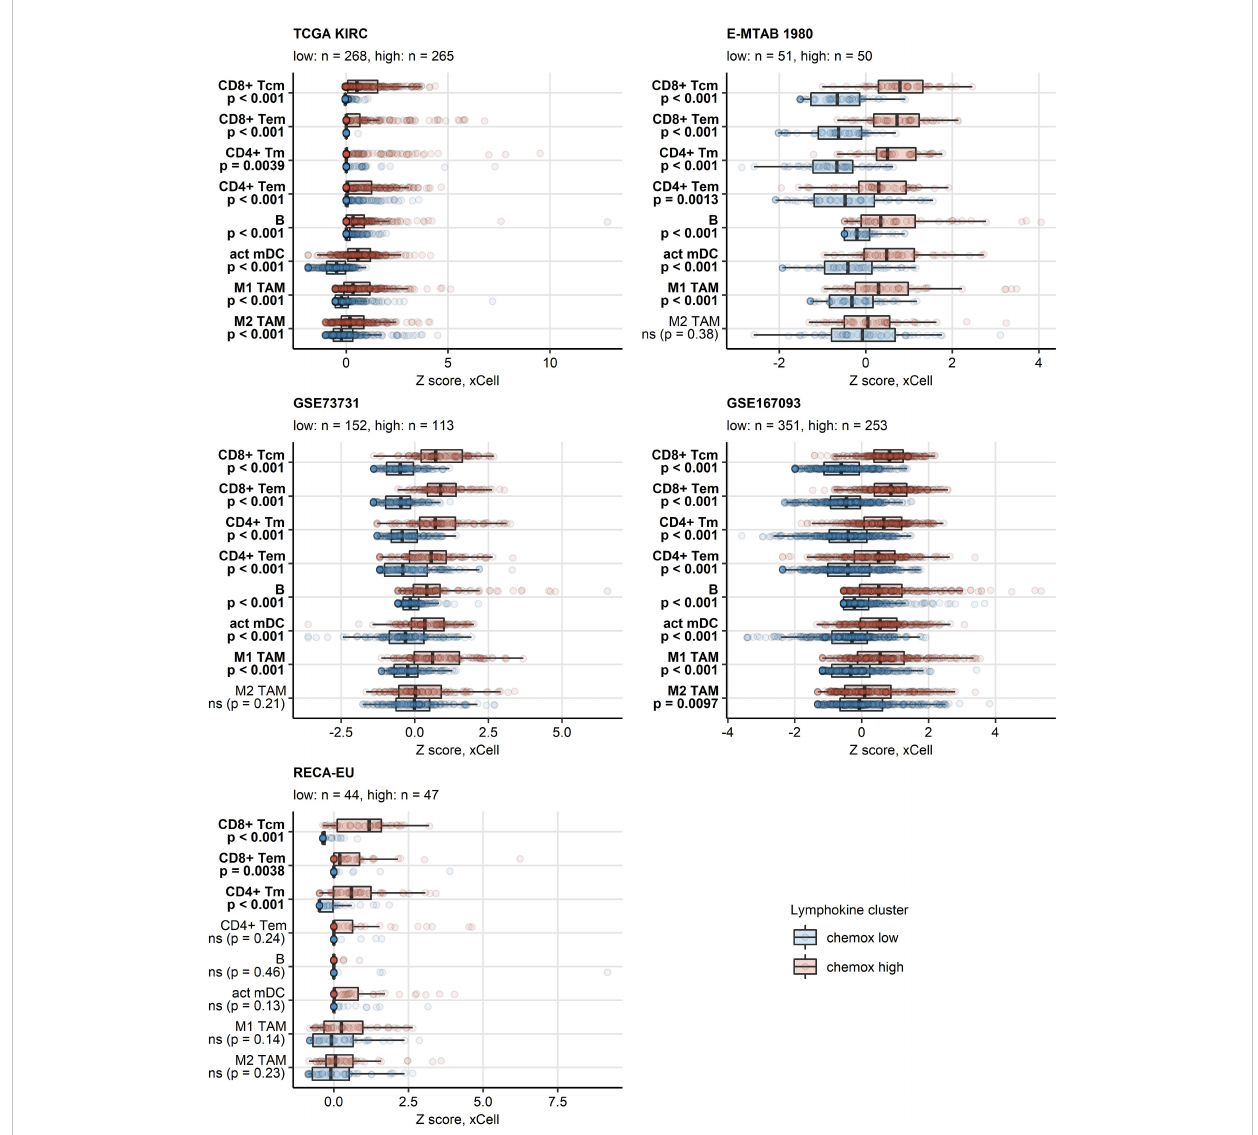
FIGURE 5 Predicted in fi ltration of T and B cells, activated mDC and TAM in the two chemokine clusters. Differences in levels of effector memory CD8 + T (CD8 + Tem), central memory CD8 + T (CD8 + Tcm), memory CD4 + T (CD4 + Tm), effector memory CD4 + T cells (CD4 + Tem), B cells (B) , activated myeloid dendritic cells (act mDC), M1 and M2 tumor-associated macrophages (TAM) between the chemokine (chemox) high an chemokine low cluster were assessed by false discovery rate (FDR) corrected Mann-Whitney test in the TCGA KIRC, E-MTAB 1980, GSE73731, GSE167093, RECA-EU collectives. Median normalized in fi ltration levels with interquartile ranges (IQR) are presented as boxes, whiskers span over the 150% IQR. Points represent single cancer samples. P values are indicated in the Y axes, signi fi cant effects are highlighted in bold. Numbers of cancer samples assigned to the chemokine high and low clusters are displayed in the plot